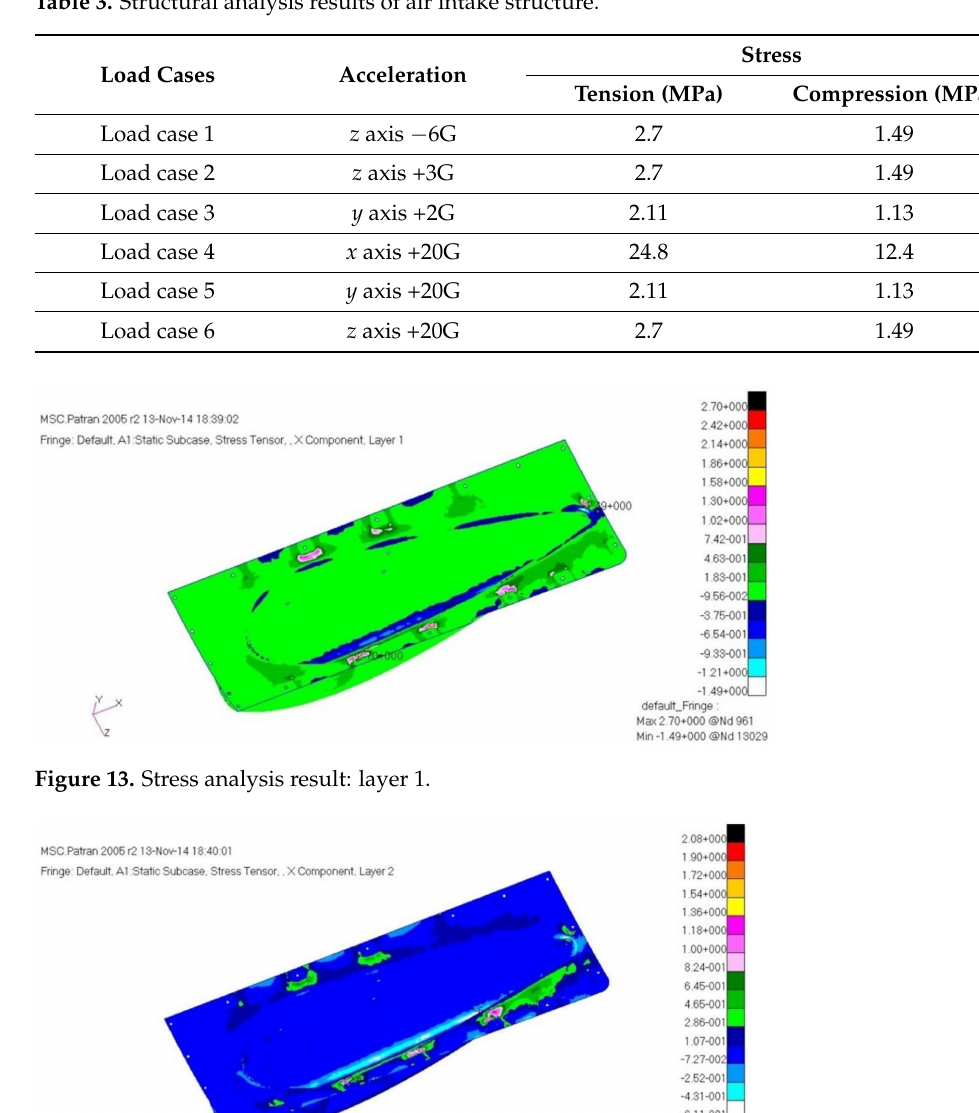
Table 3. Structural analysis results of air intake structure.